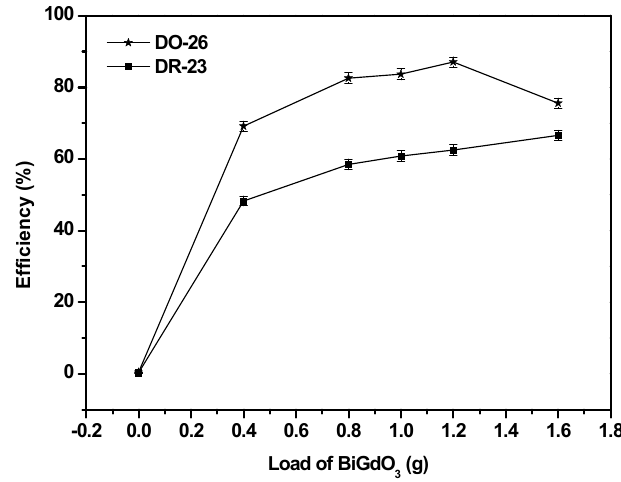
Figure 11. Effect of the catalyst loading on the photocatalytic degradation efficiency of Direct Orange 26 or Direct Red 23.